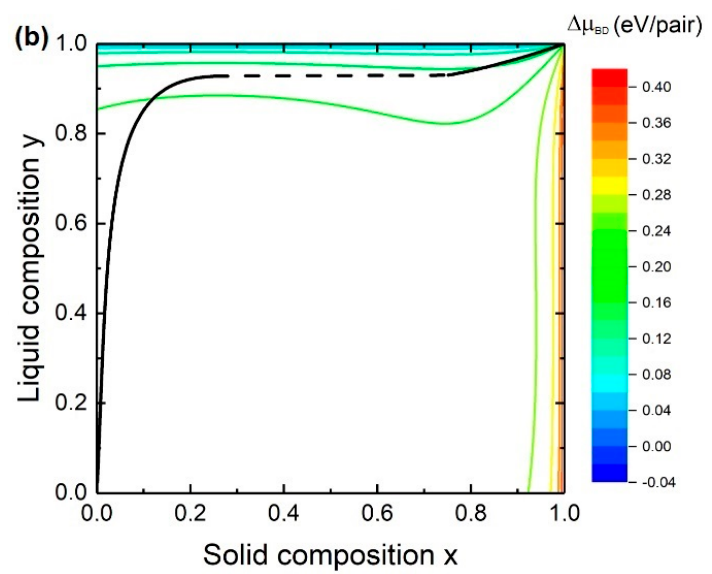
Figure 2. Dependence of the steady-state solid composition on the liquid composition for In x Ga 1 − x As NWs and contour plots of chemical potential differences between the species AD ( a ) and BD ( b ) in the liquid phase and the solid phase. Dashed lines indicate miscibility gaps.